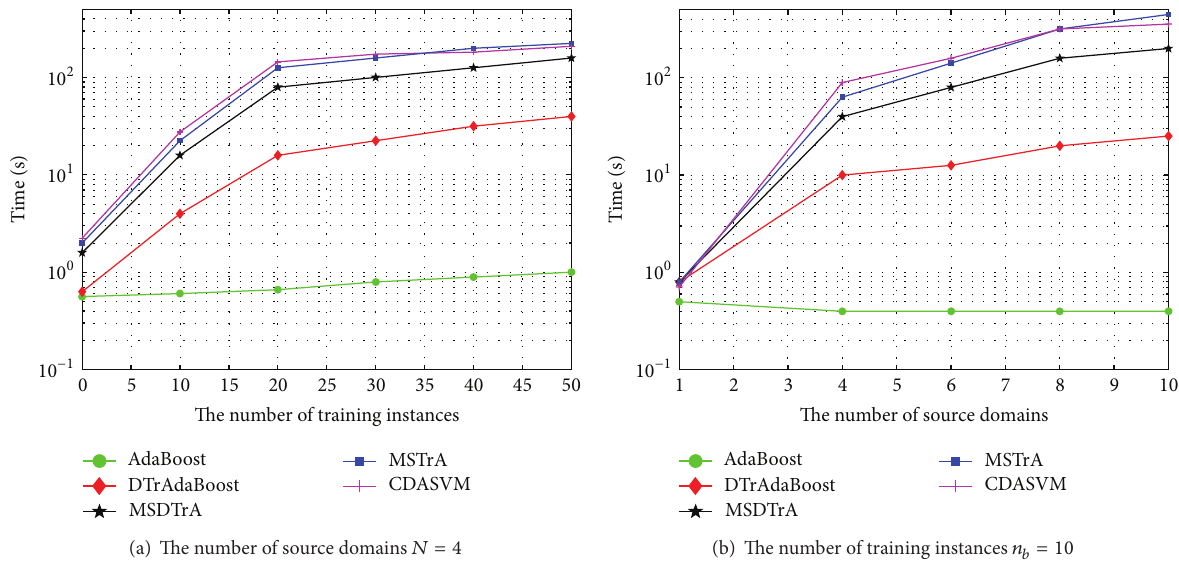
Figure 3: Time cost comparison on different